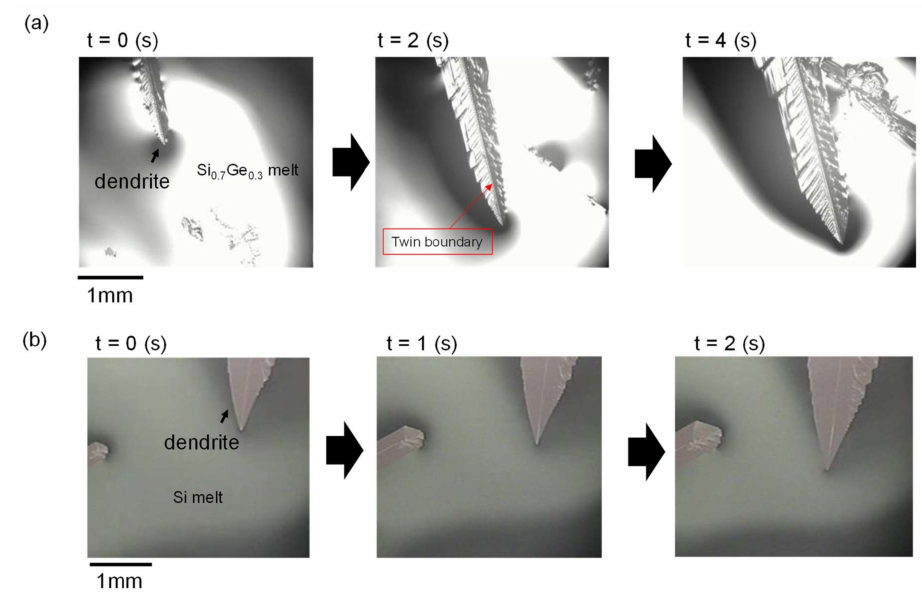
Figure 2. In situ observations of growing dendrites in ( a ) Si 0.7 Ge 0.3 melt and ( b ) pure Si melt.